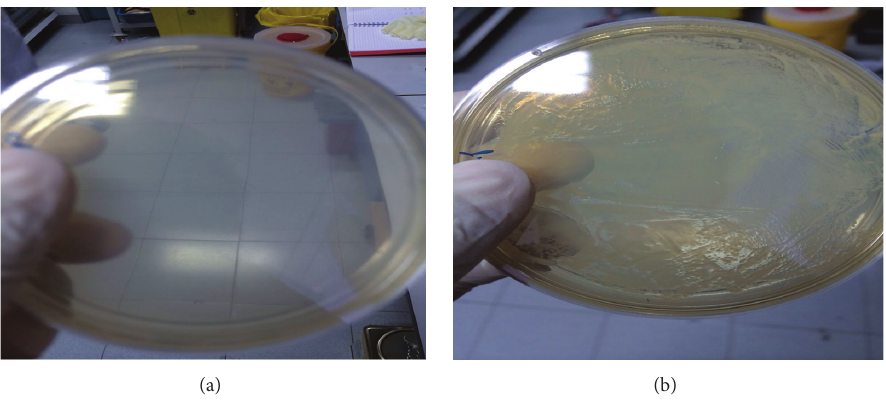
Figure 6: Petri dish of E. coli plated (a) containing 125 𝜇 g/mL AgNPs and (b) control.